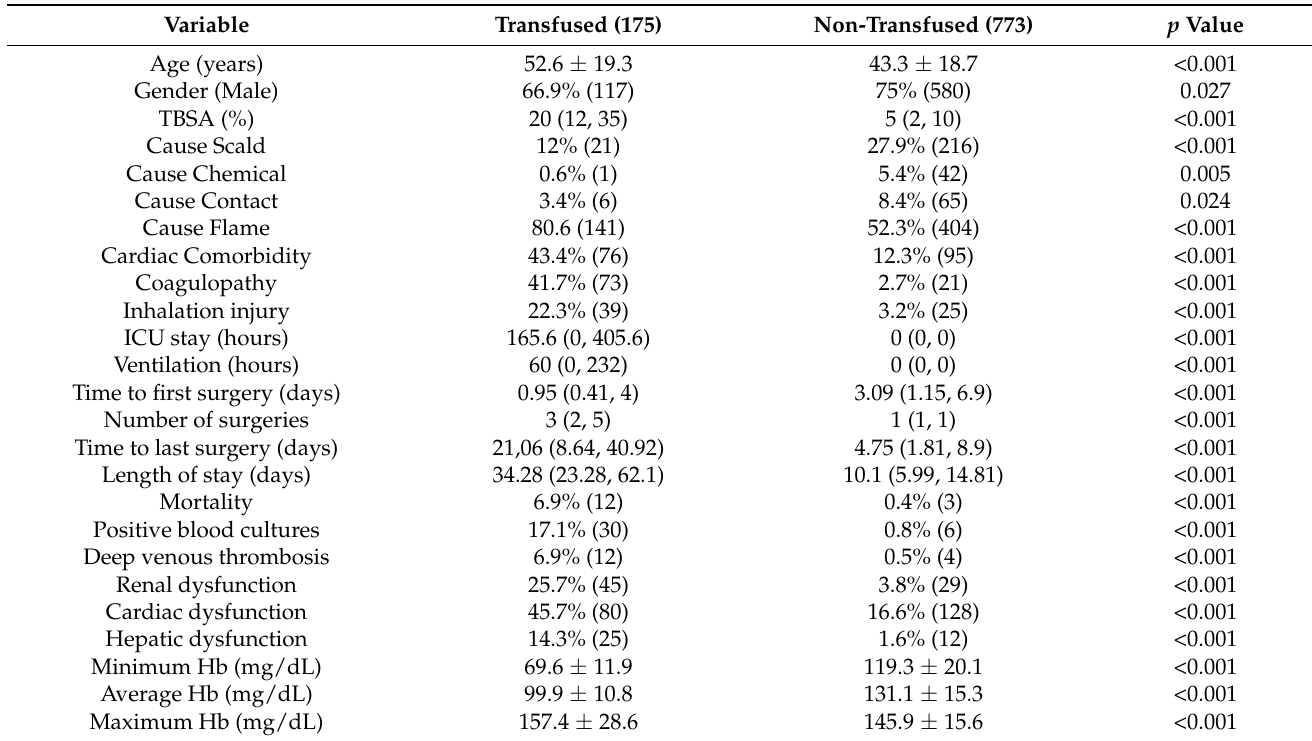
Table 1. Summary of all surgical patient